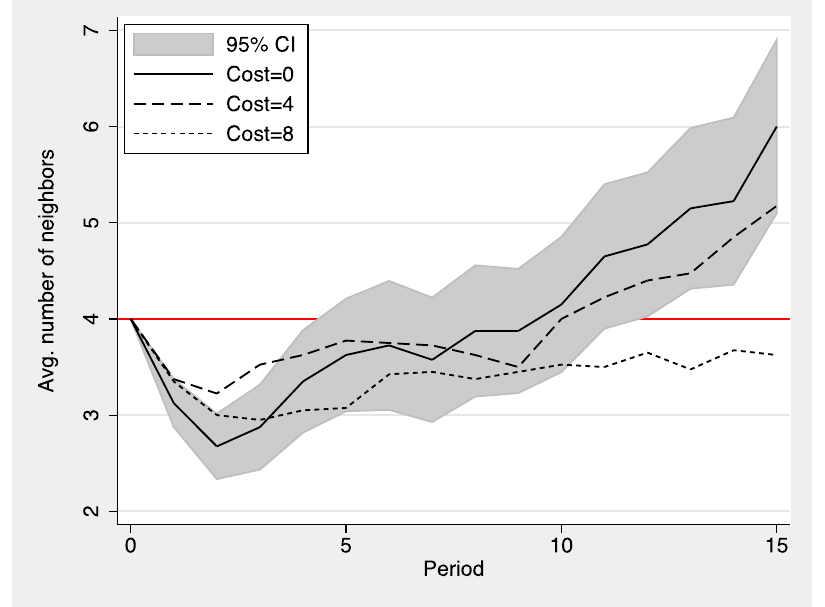
Figure 3. Average number of neighbors by period and treatment (cost of information). The grey area plots the 95% CI for the cost=0 treatment.